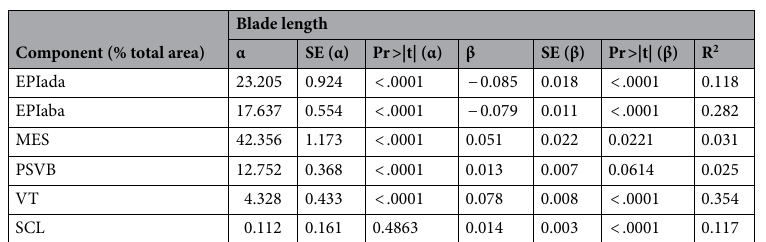
Table 2. Linear regression between final blade length and the percentage of anatomical tissues along the elephant grass leaves (phytomers 8 to 16). MES mesophyll, PSVB parenchymatic sheath of vascular bundles, VT vascular tissue, SCL sclerenchyma, EPIada adaxial epidermis and EPIaba abaxial epidermis. α intercept, SE standard error, β slope.